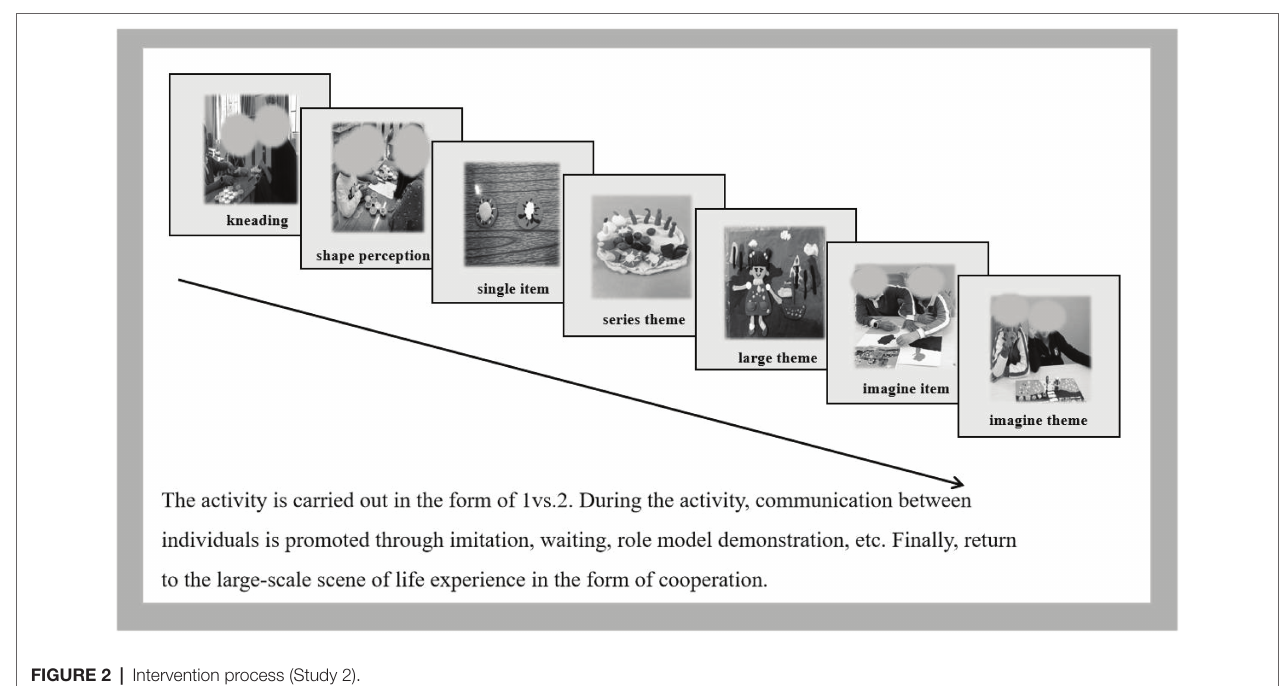
FIGURE 2 | Intervention process (Study